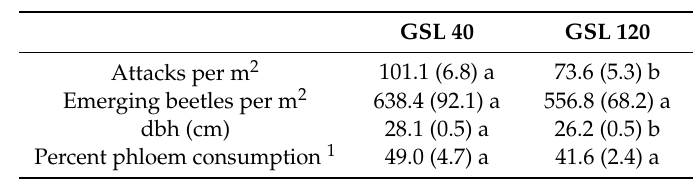
Table 2. Mean (SE) Dendroctonus ponderosae (MPB) emergence and attacks per m 2 , diameter at breast height (dbh) of Pinus contorta sample trees, and phloem consumption in trees in growing stock levels (GSL) 40 and 120, n = 40 for each GSL. All means followed by SE in parenthesis. Different letters across rows indicate significant differences at p < 0.05, Tukey’s studentized range test, Fraser Experimental Forest and Colorado State Forest, CO,